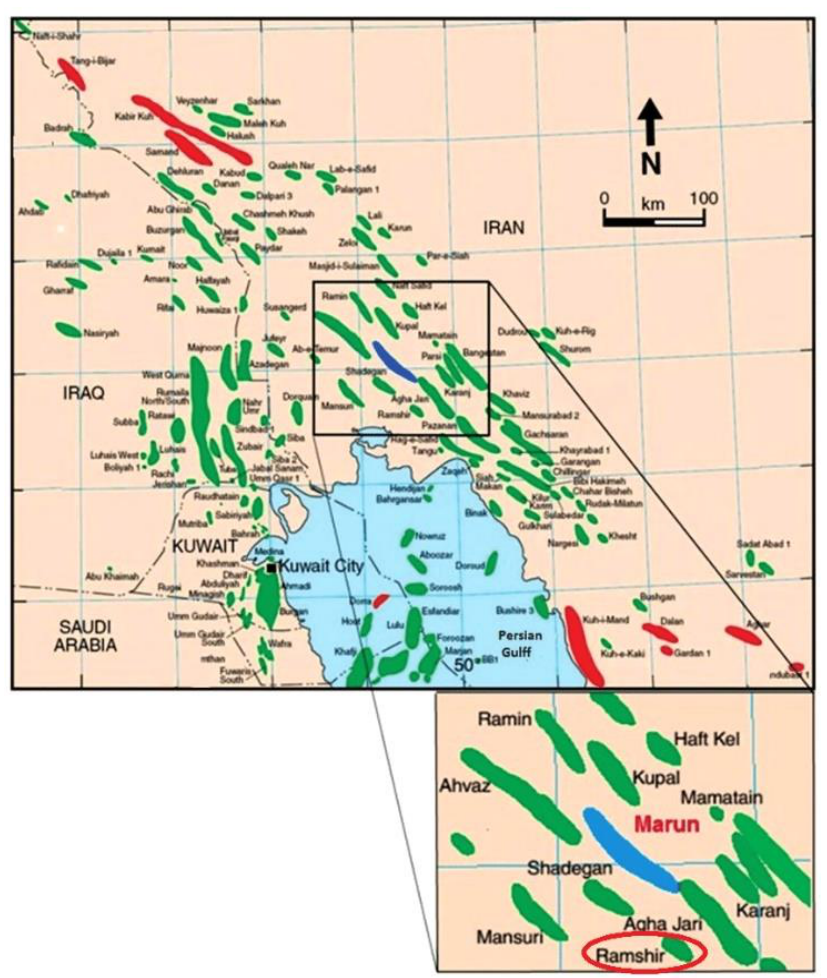
Figure 1. Geographical location of the study area in south-western